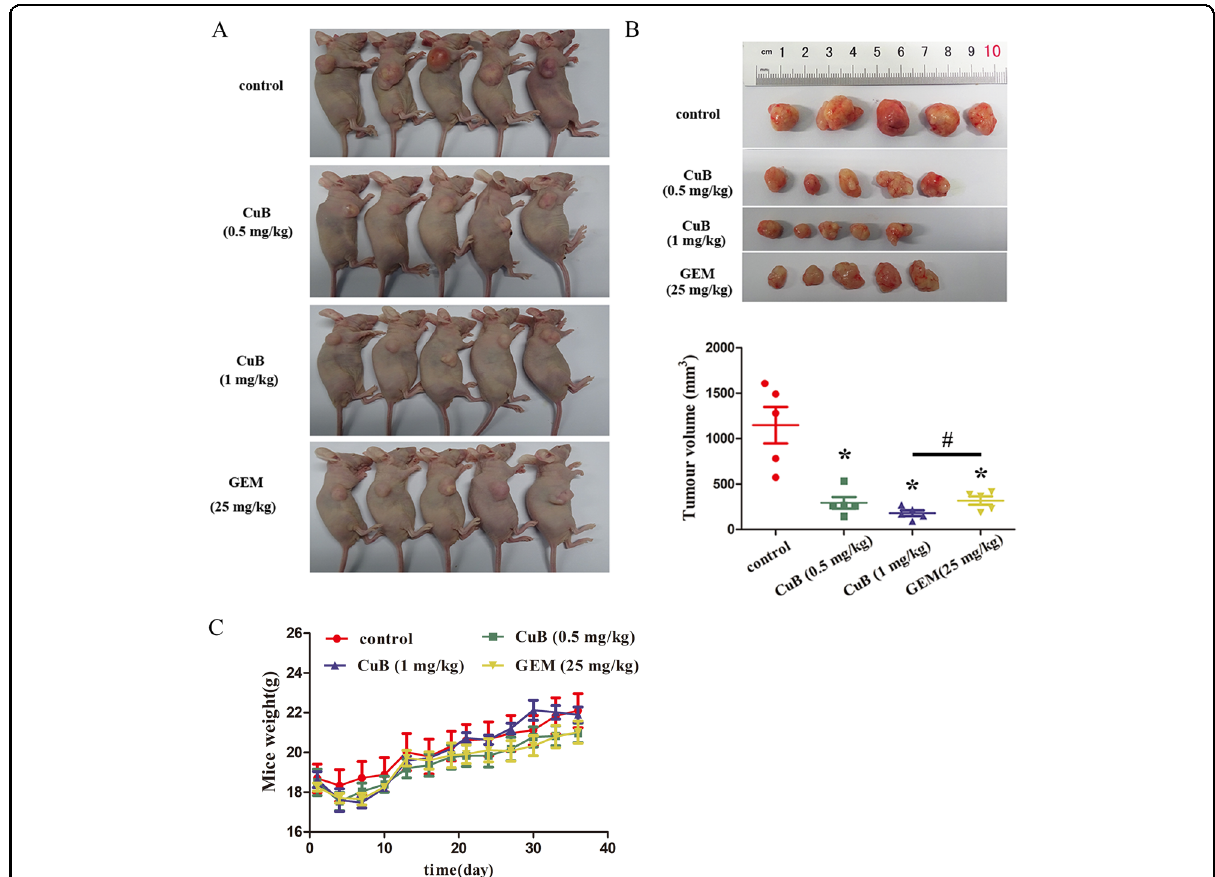
Fig. 7 In vivo anti-tumour effect of CuB. A Images of euthanized mice with or without the administration of CuB (0.5, 1 mg/kg) and GEM (25 mg/ kg). B Images of excised tumour bulks and fi nal average tumour volume in each group. C Body weight of mice from each group during the whole observation period. Data were presented as the mean ± SEM, * p < 0.05 vs. the control group by t -test using GraphPad Prism 5.0, n = 5. # p < 0.05 for between group comparisons by one-way ANOVA using GraphPad Prism 5.0, n =